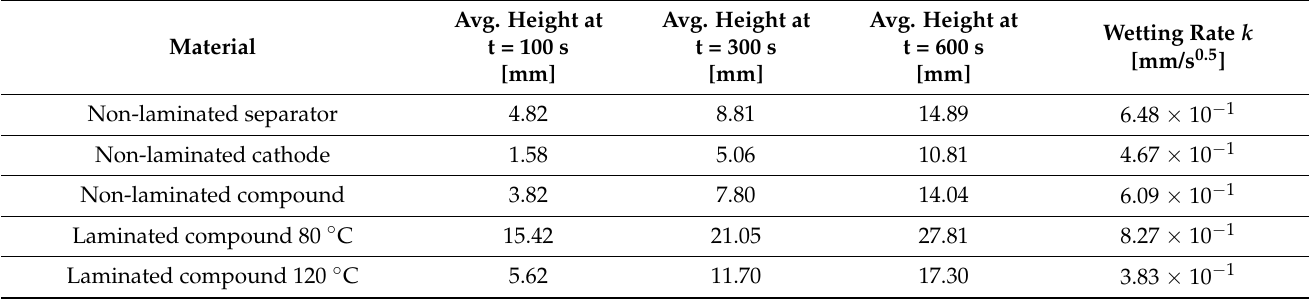
Table 2. Average heights at three time-points and evaluated parameters wetting rate k for the cathode separator measurement series (i) to